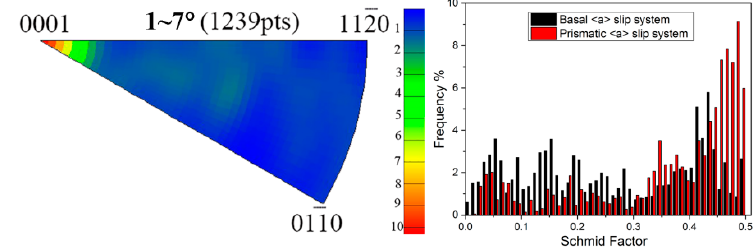
Figure 7. The corresponding in-grain misorientation axis analysis with misorientations in the range of 5–10 ◦ obtained by EBSD and the Schmid factor distribution of prismatic < a > and basal < a >